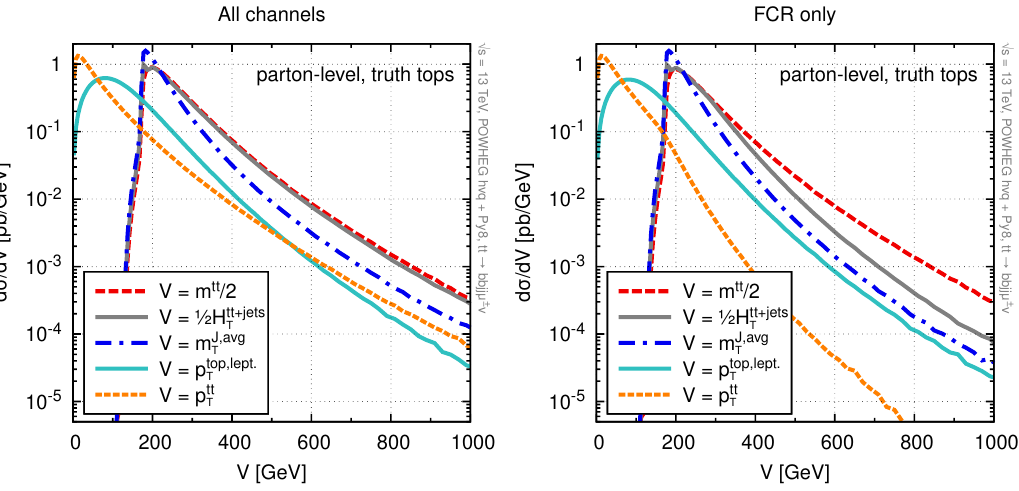
Figure 4 . Differential cross sections as a function of a variety of variables used to characterise the event hardness ( V ), considering an illustrative subset of the variables from table 1. Left-hand plot: results summing over all topologies. Right-hand plot: results for just the FCR